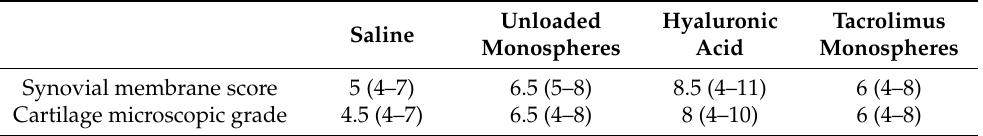
Figure 5. Representative histological images (10× magnification). Cartilage stained with safranin O and synovial tissue stained with H&E. Monospheres in the synovial tissue are indicated with an asterisk (*). Table 2. Synovial membrane and cartilage microscopic scores according to the scoring system described by Mcllwraith et al. 2010 [41]. Scores are depicted as median (range), and the maximum score is 20 for both scores. No significant differences between treatments were